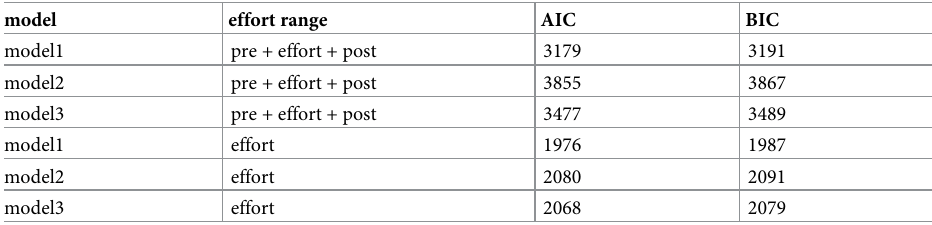
Table 2. Akaike information criterion (AIC) and Bayesian Information criterion (BIC) for the models 1, 2 and 3 in Eq 2 when applied to the ensemble of the SDRR computed on different part of the exercise test: Before test (pre), during test (effort) or during recovery